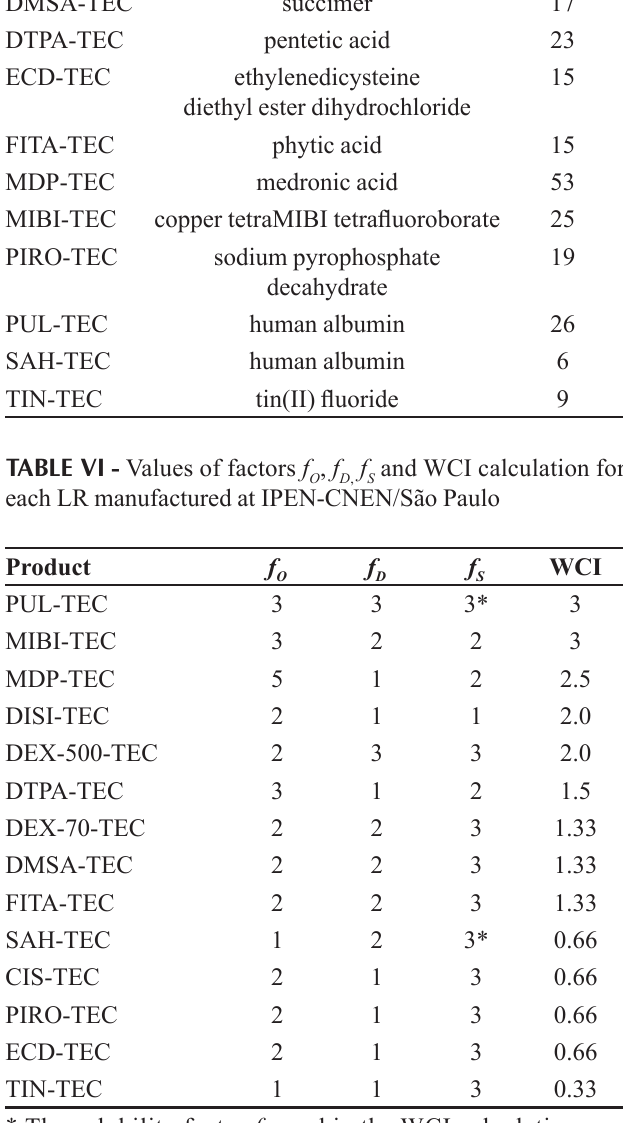
TABLE V - Lot numbers of LR manufactured at IPEN-CNEN/ São Paulo in 2013